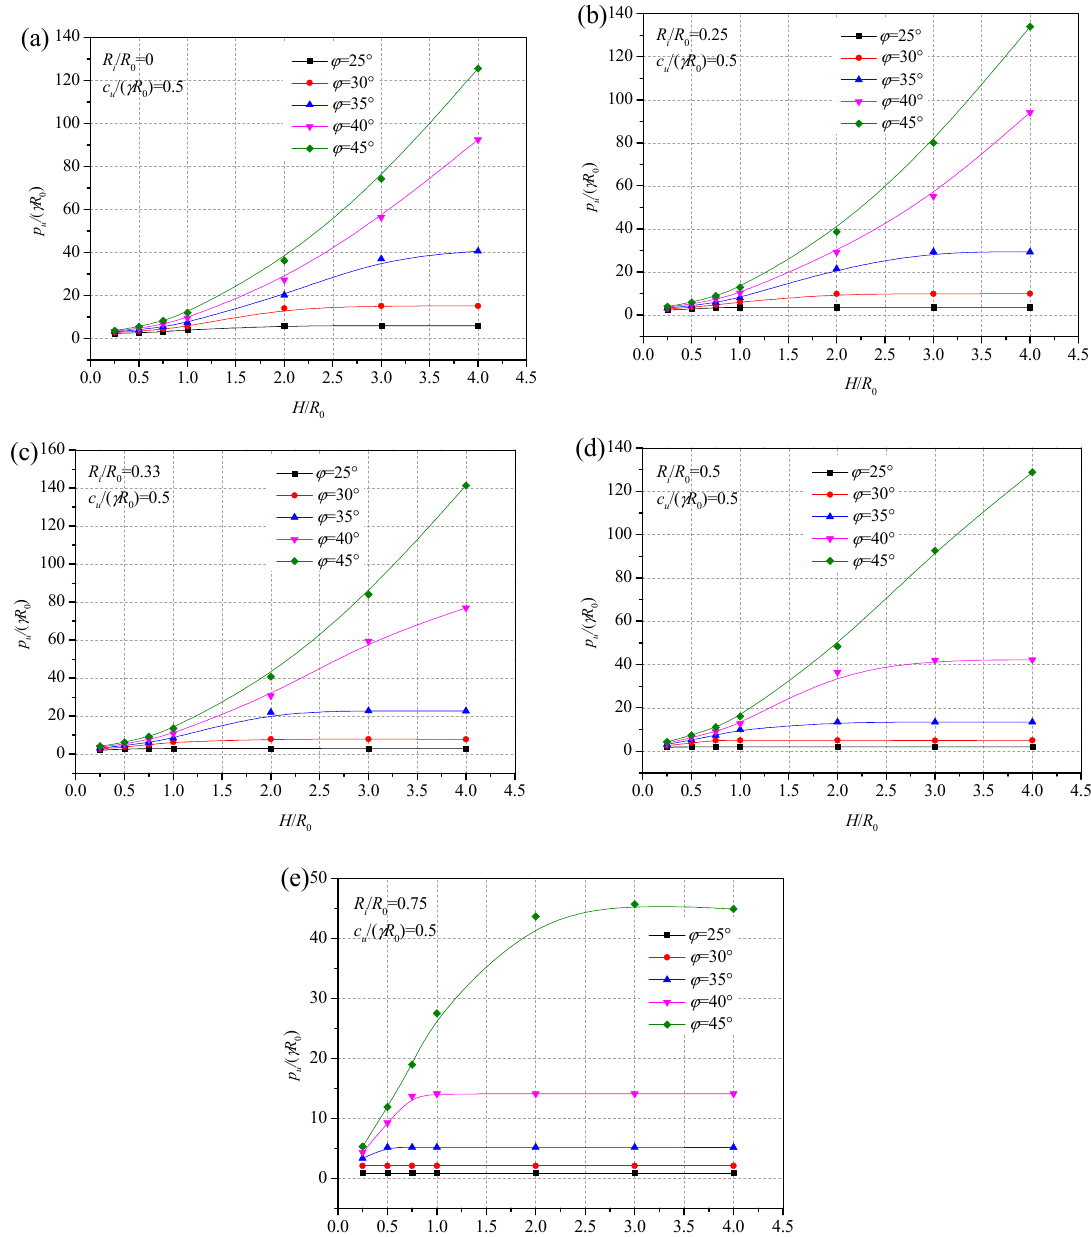
Figure 6. Variation in the normalized bearing capacity, p / ( γ R 0 ), with H / R 0 and ϕ for c u / ( γ R 0 ) = 0.5 with (a) R i / R 0 =0, (b) R i / R 0 =0.25, (c) R i / R 0 =0.33, (d) R i / R 0 =0.5, and (e) R i / R 0 =0.75.